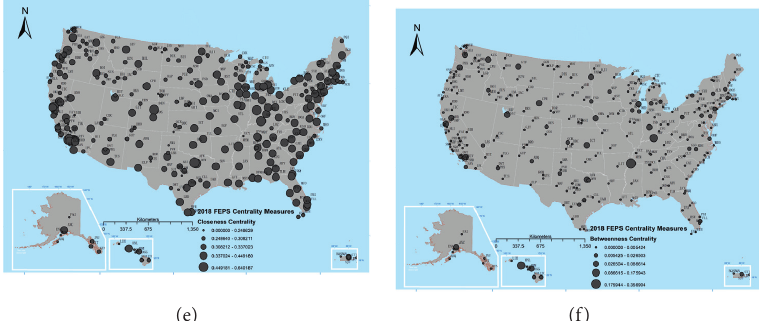
Figure 3: Spatial distribution of degree centrality, closeness centrality, and betweenness centrality of FEPS air cargo network in 2008 and